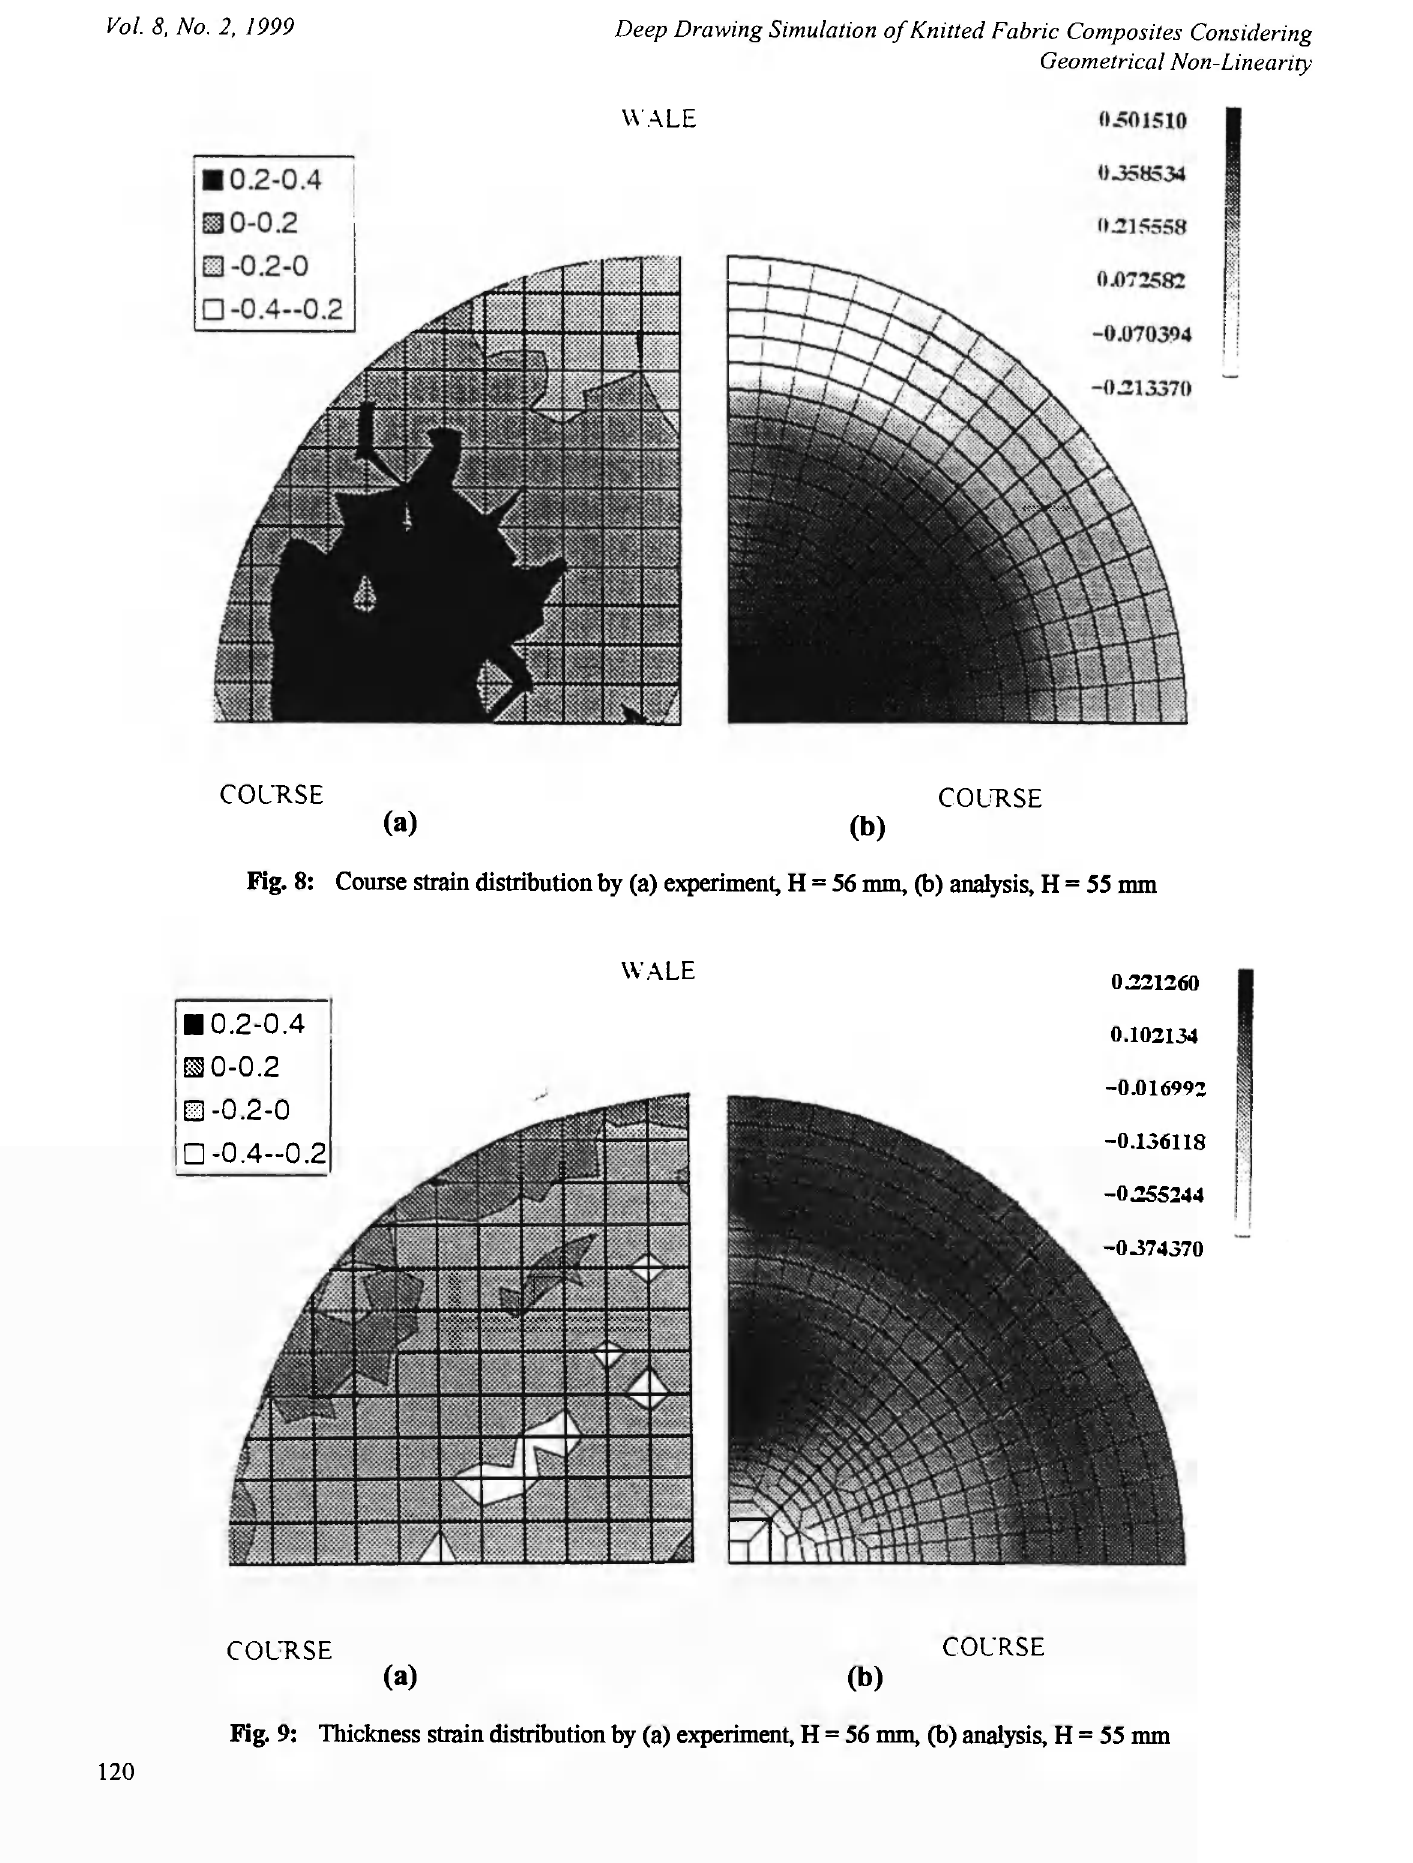
Fig. 8: Course strain distribution by (a) experiment, Η = 56 mm, (b) analysis, Η = 55 mm